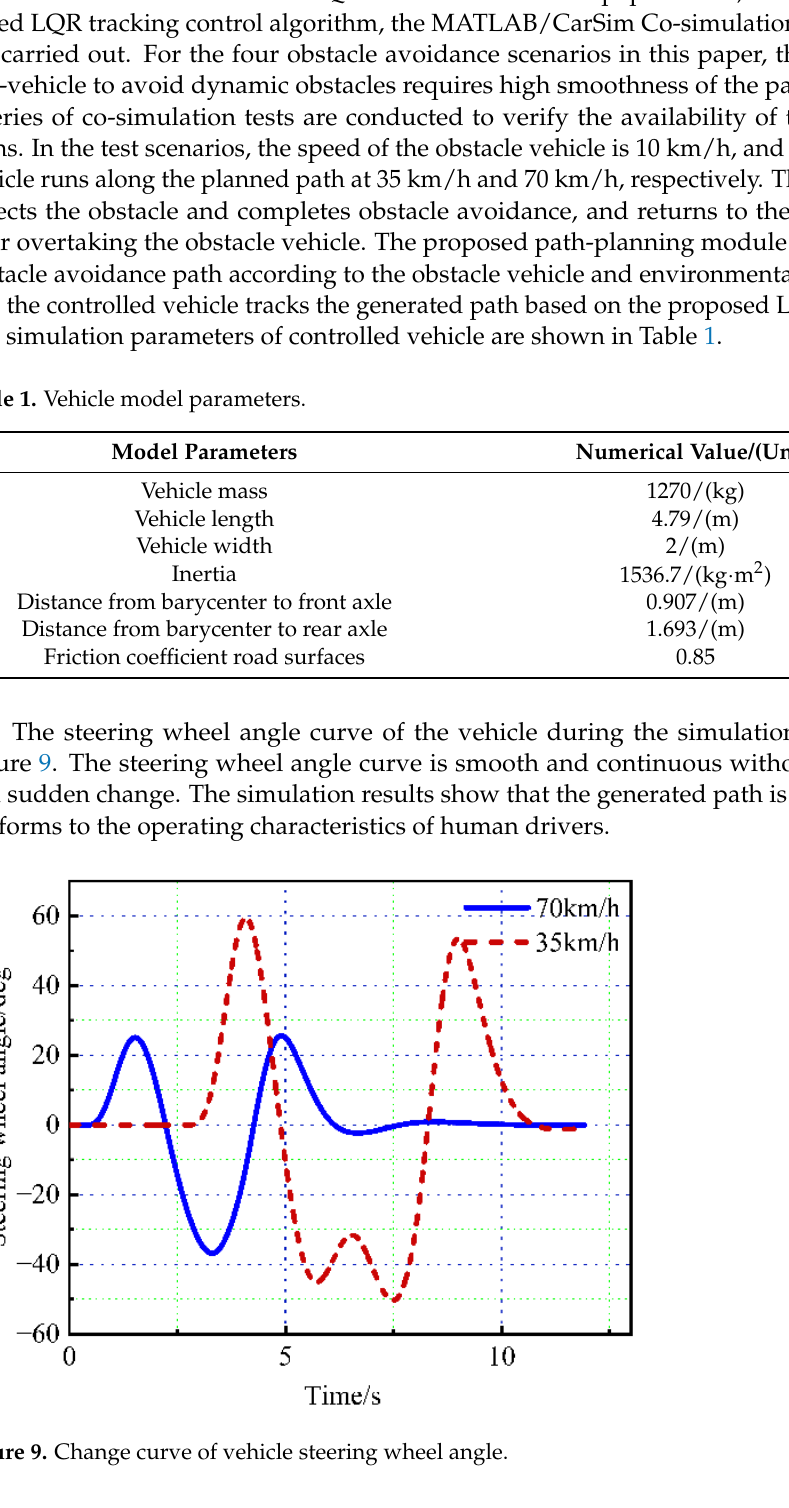
Figure 9. Change curve of vehicle steering wheel angle.